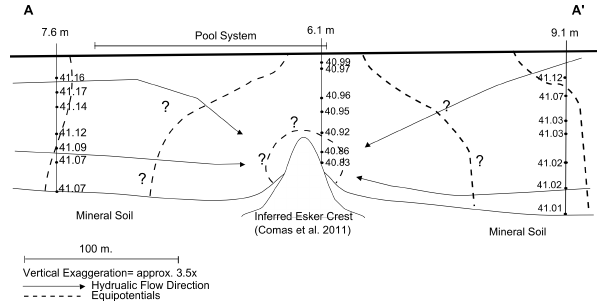
esker crest is driving down flow that may drive a downward trans- port of labile carbon to deeper peat and increase FPG